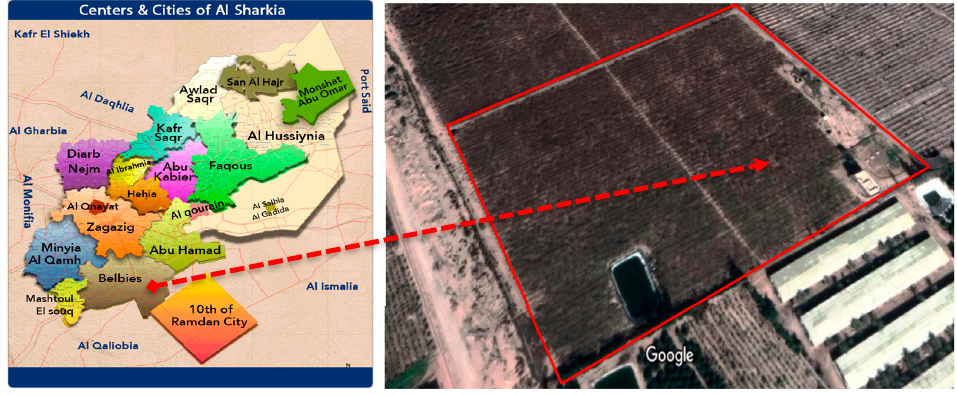
Figure 1. The experimental site, Bilbeis city, Sharqia Governorate, Egypt; Source: Sharqia Governorate Site and Google Maps. Table 1. Some physical properties of the soil for Bilbeis experimental site.